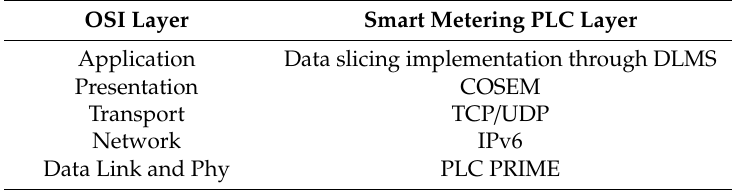
Table 3. PRIME smart energy meters Open Systems Interconnection (OSI) layers